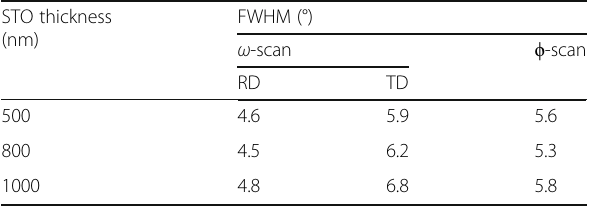
Table 1 FWHM of ω -scans RD and TD of (002) peak and ϕ -scan at ψ = 54.74° of (111) peak for (100) STO films deposited at a chamber pressure, laser frequency, and substrate temperature of 10 − 4 mbar, 10 Hz, and 500 °C, respectively, with different thickness